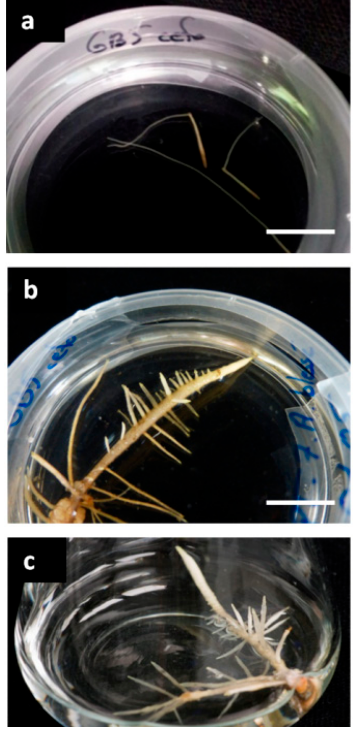
Figure 1. Observations of the different phenotypes of roots isolated:( a ) roots from the first series isolated after the second subculture (28 days); ( b ) roots from the second series isolated after the second subculture (21 days of culture); and ( c ) roots from the second series after 40 days growth in 100-mL shaken flasks with 20 mL culture medium. Bars represent 1 cm.